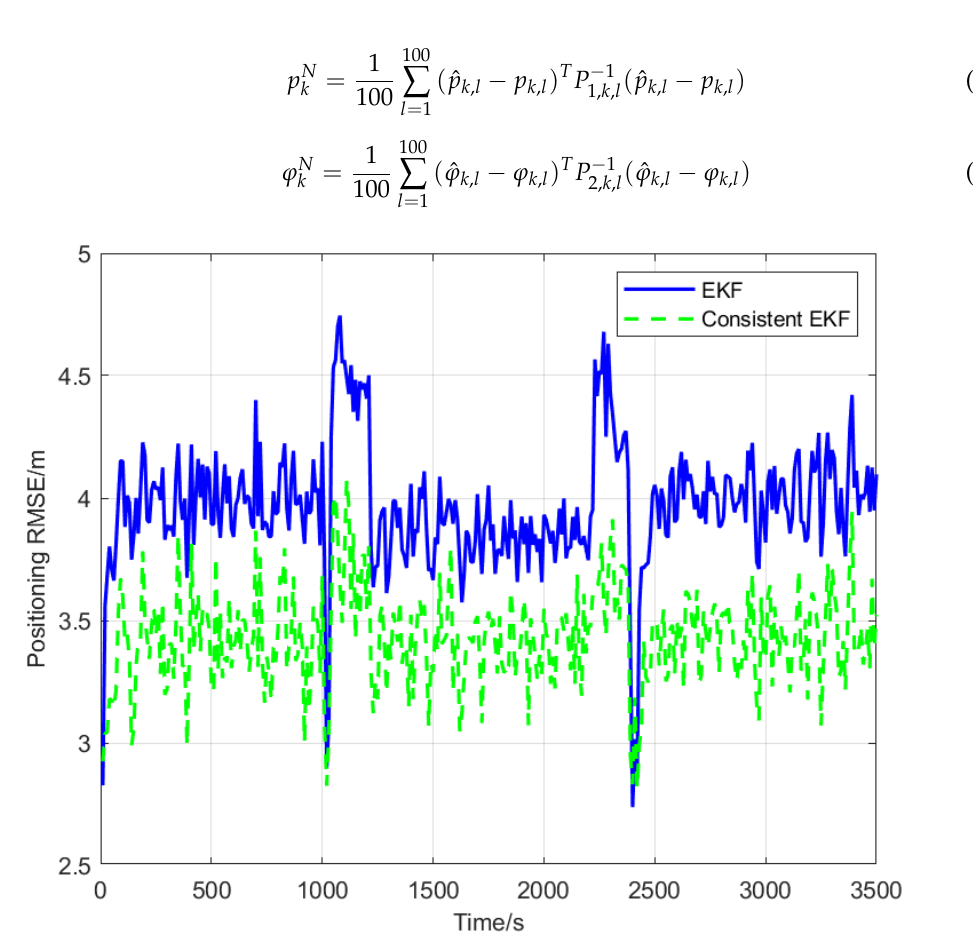
Figure 4. Root mean square errors of position.